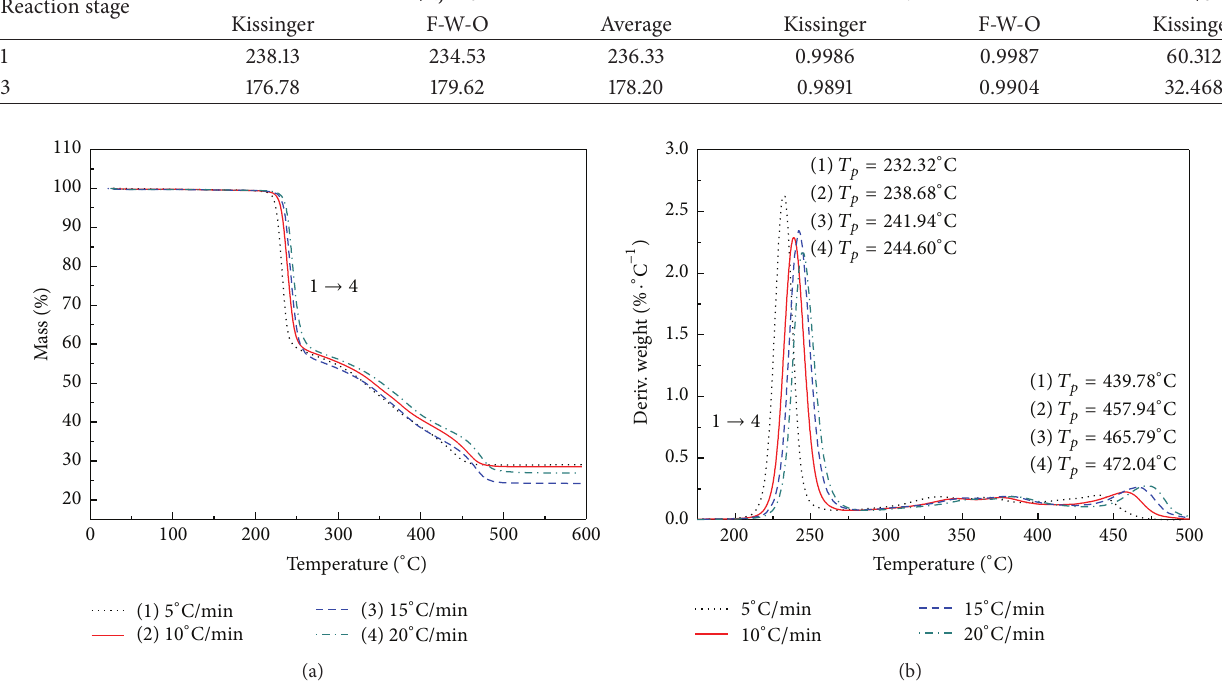
Table 3: Calculated results for the complex kinetic parameters of thermal decomposition using Kissinger and F-W-O methods. Reaction stage